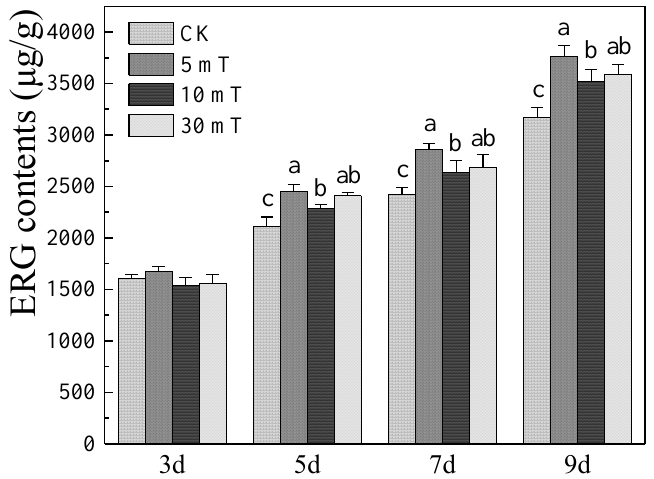
Figure 6. Ergosterol (ERG) produced by M. ruber M7 under SMF. The error bars indicate the standard deviations of three independent cultures. Lowercase letters signify a p -value < 0.05.